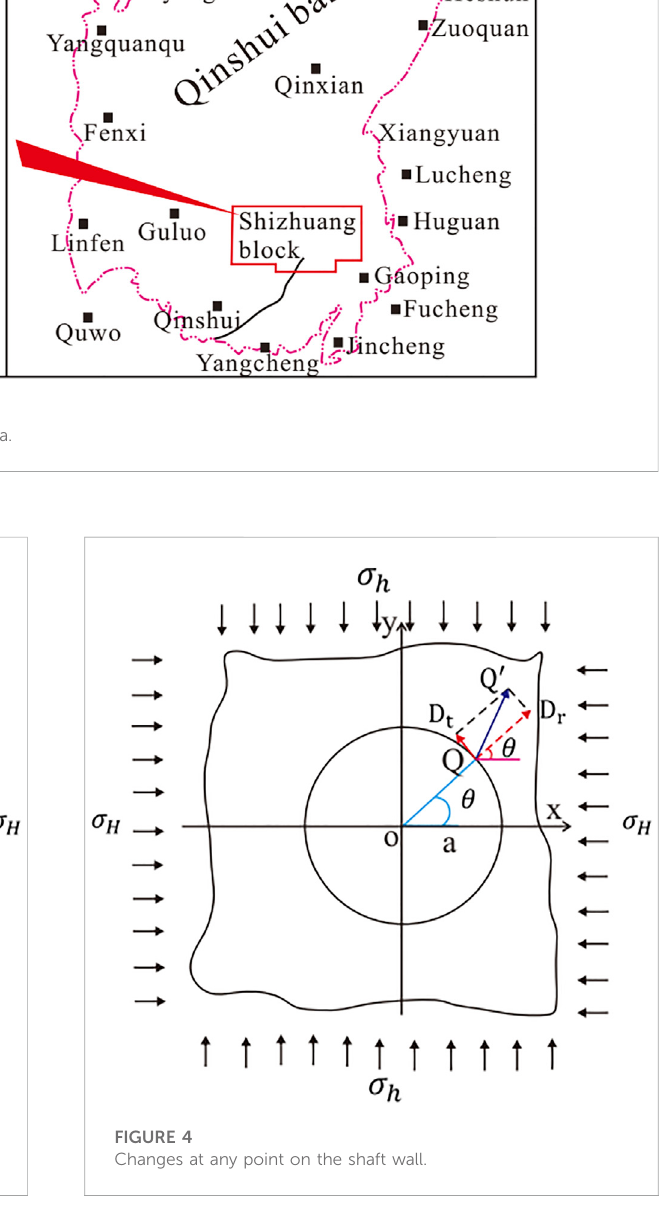
FIGURE 3 Schematic diagram of borehole displacement.